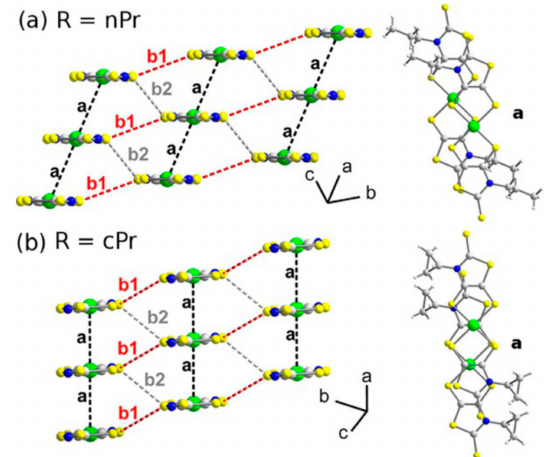
Figure 6. One-dimensional molecular arrangement in the crystals of Au(R-thiazdt) 2 : ( a ) R = n Pr; ( b ) R = cPr. For R-thiazdt, see Figure 4. The dotted lines show intermolecular interactions designated as a, b1 and b2. Compared with a, b1 and b2 are evidently small, resulting in a columnar structure along the a -axis in both compounds. Reproduced from Ref. [50] with permission. Copyright 2017, Wiley.